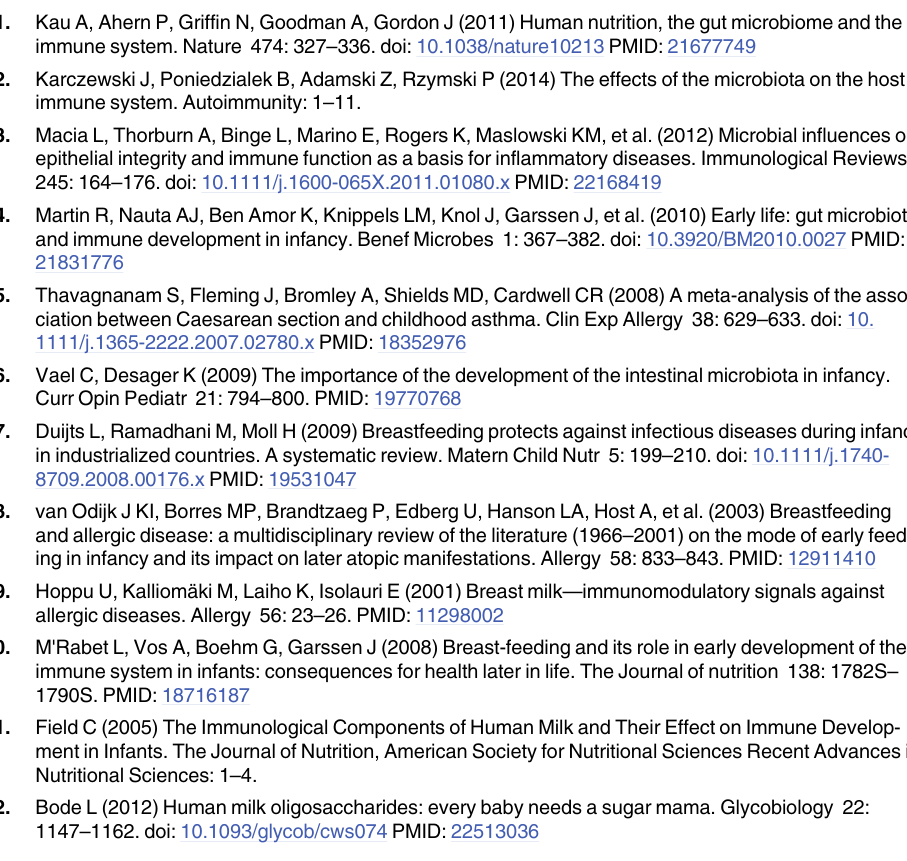
S6 Fig. Gating strategy by means of CD4 + responder only control. T cells of allogeneic stim- ulation assays (ASA) were harvested on day seven and co-incubated with freshly isolated, vio- let-labeled responder CD4 + T cells a ratio of 1:1 for five days in presence of anti-CD3/28 and rhIL-2. The mix of ASA cells and violet stained responder CD4 + T cells was then stained (after five days of co-incubation) with CD4 APC-Cy7. The gating strategy (obtained by CD4 + responder cells only) is demonstrated which was used to calculate the suppressive functionality index shown in Fig 7. Dividing T cells (P4) and non-dividing T cells (P3) were derived out of the CD4 + gate. ASA = allogeneic stimulation assay.